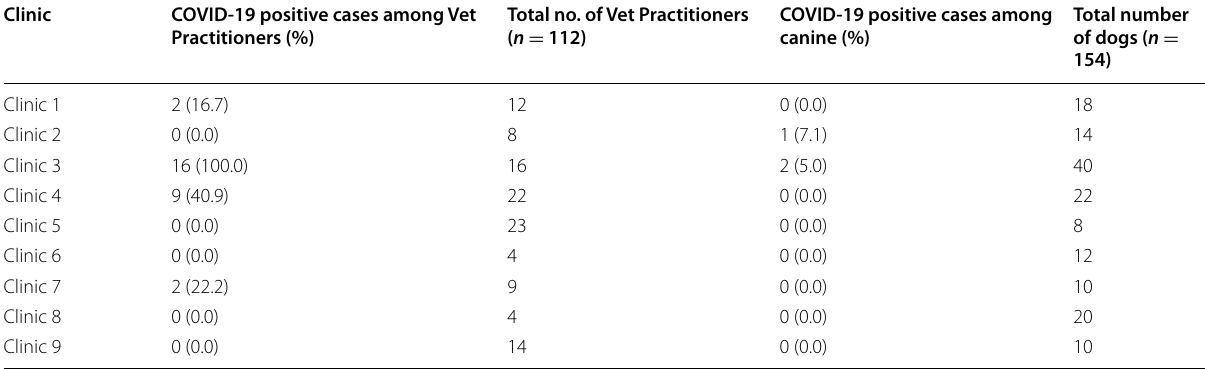
Table 3 COVID-19 cases among veterinary practitioners and dogs presented at clinics in Lagos, June – August 2020 Clinic COVID-19 positive cases among Vet Practitioners